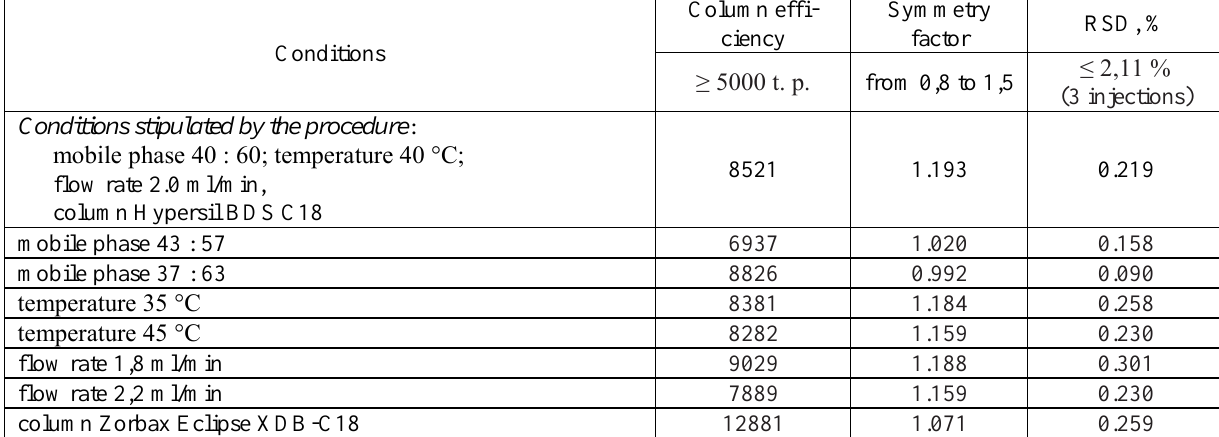
The results of the study in regard to the robustness of the analytical procedure for the quantitative determination of